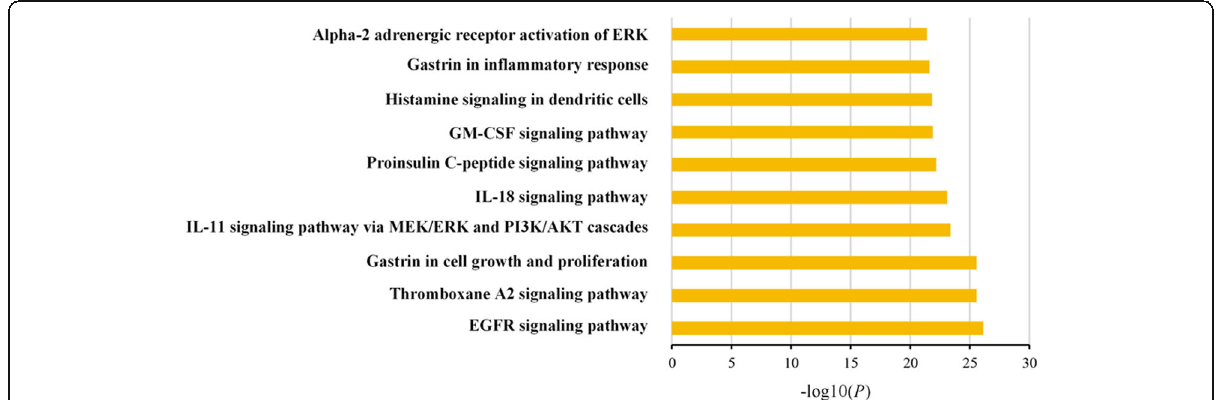
Fig. 2 Main pathways enriched by major hubs from Metacore database. The top 10 pathways measured by counts were selected to demonstrate the crucial biological actions of major hubs. The abscissa stands for target counts in each pathway; and the ordinate stands for main